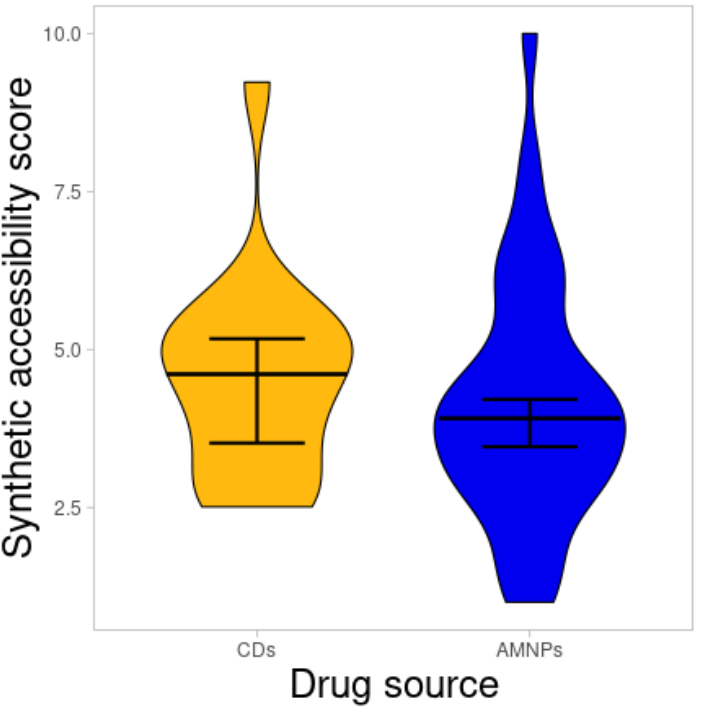
Figure 12. Violin plot of synthetic accessibility for CDs compared with AMNPs. The line that divides the boxes represents the median of the distributions. The black bars indicate a 95% confidence interval.